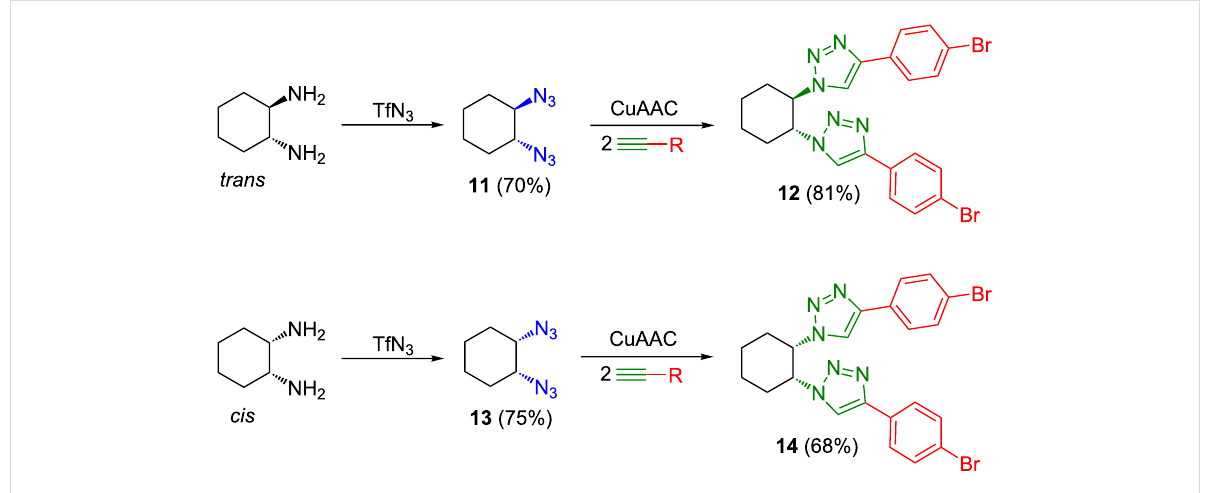
Scheme 4: Synthesis of (1 R ,2 R )- and (1 R ,2 S )-1,2-bis-(4-(4-bromophenyl)-1 H -triazol-1-yl)cyclohexane ( 12 and 14 ).